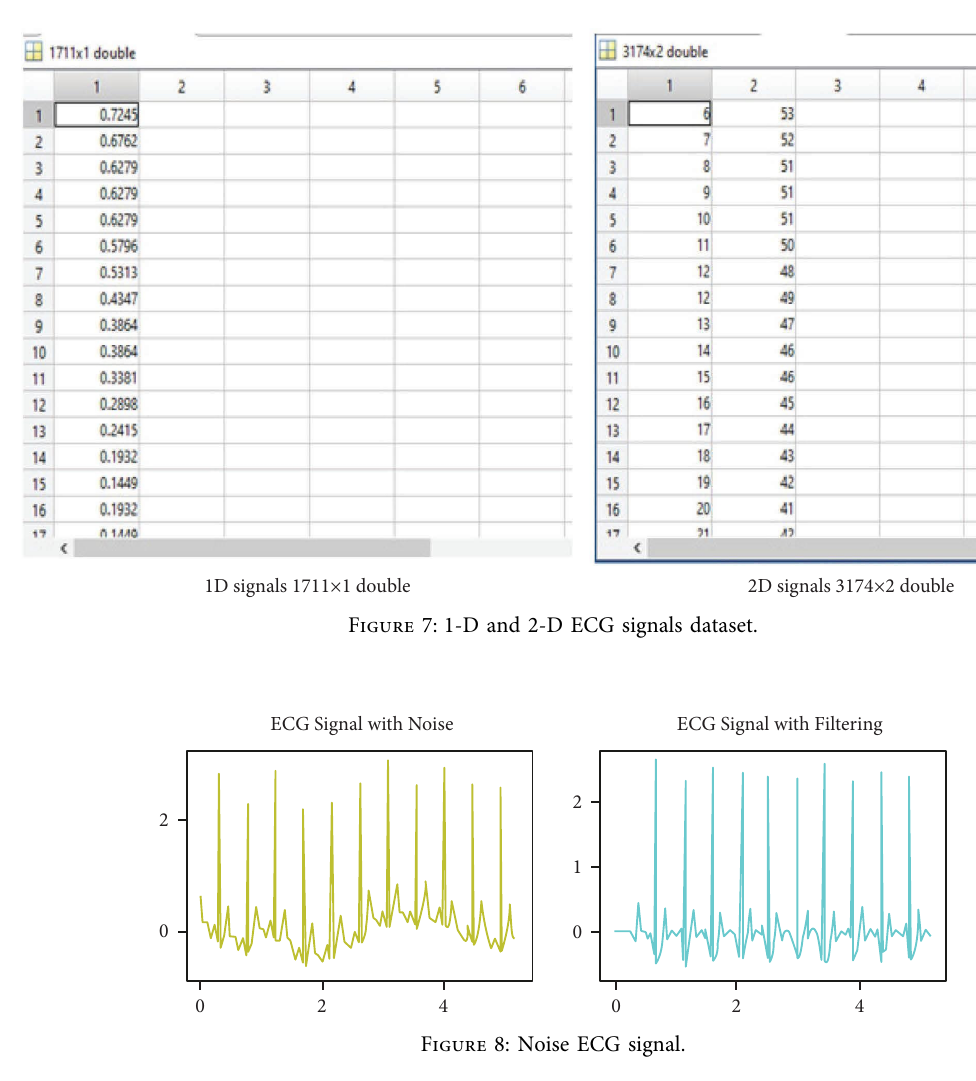
Figure 8: Noise ECG signal.